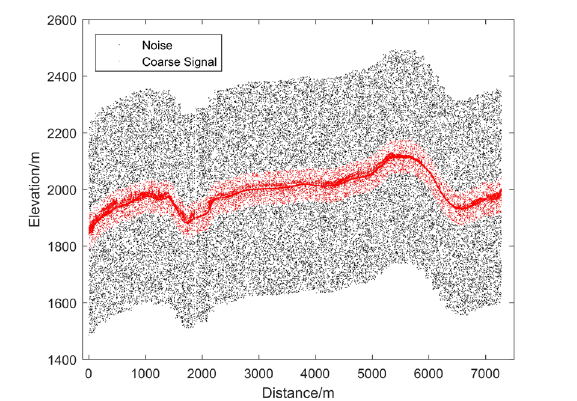
Figure 7 . Filter result based on local distance feature.